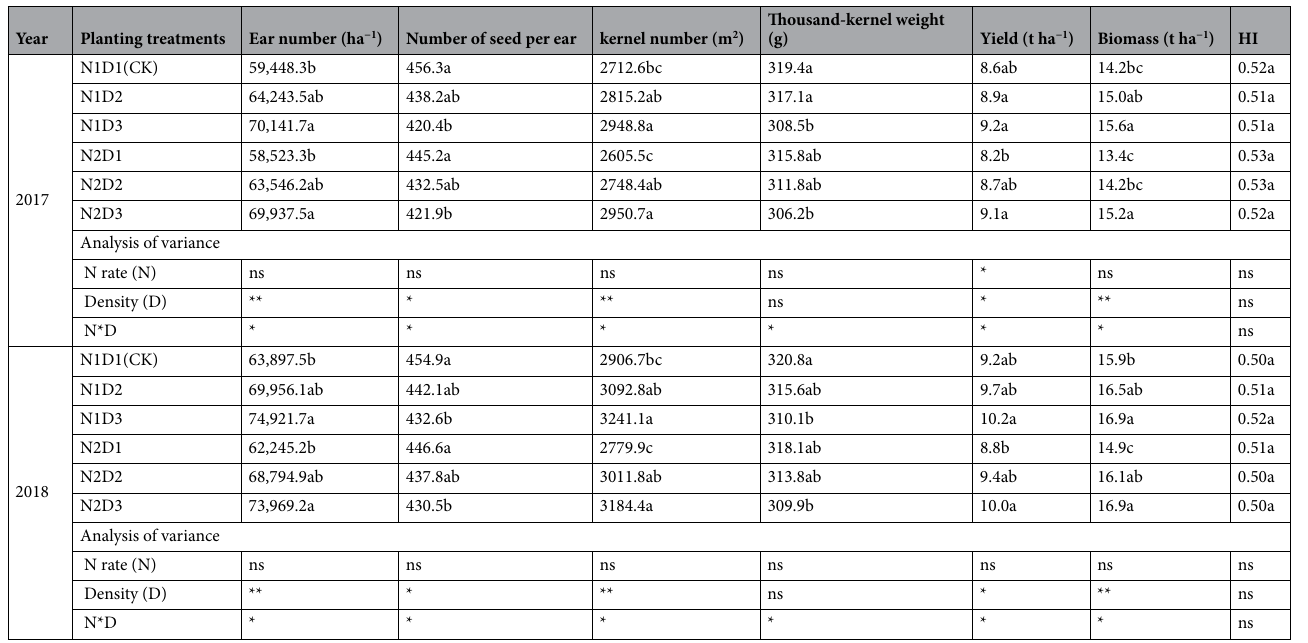
Table 1. Yield and yield components of maize in different planting treatments in 2017 and 2018. Values followed by different letters within a column are significantly different ( P < 0.05). HI harvest index, ns